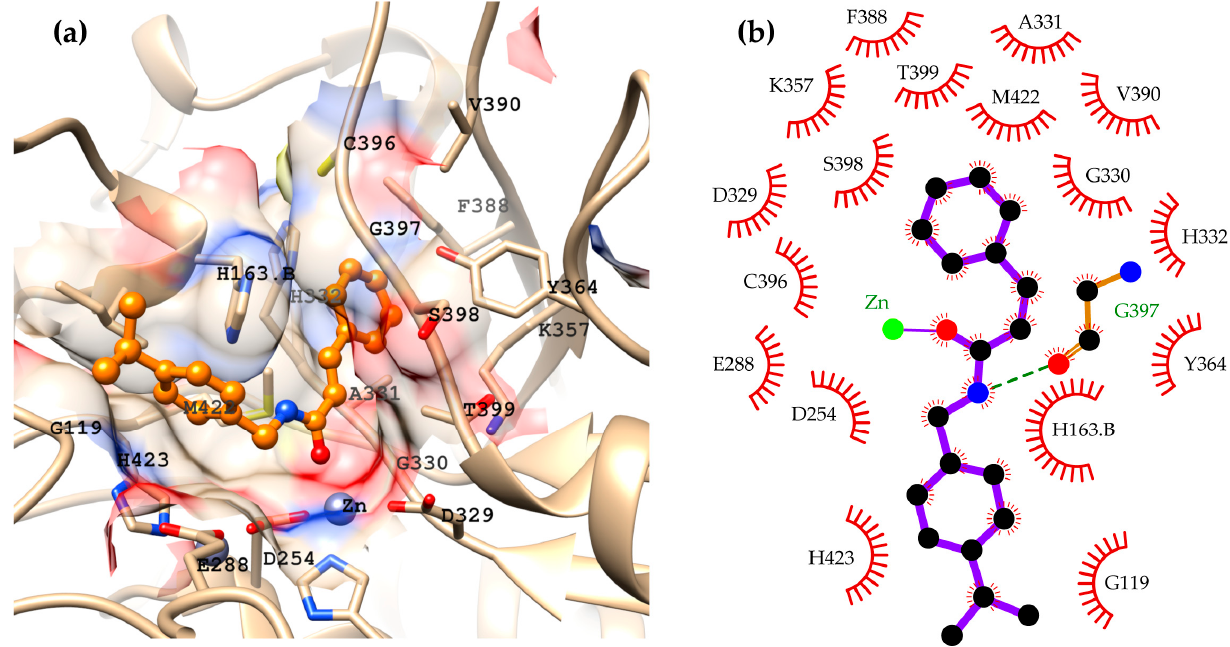
Figure 3. Predicted binding mode of compound 32 to AAP ( a ) and predicted ligand–receptor interactions ( b ). On the left, the ligand is represented in orange balls and sticks, while the receptor is depicted in tan. Nitrogen atoms are colored blue, oxygen atoms red, and sulfur atoms yellow. Only receptor residues interacting with the compound in at least 50% of the examined MD snapshots are labeled in the complex structure and represented in the interactions